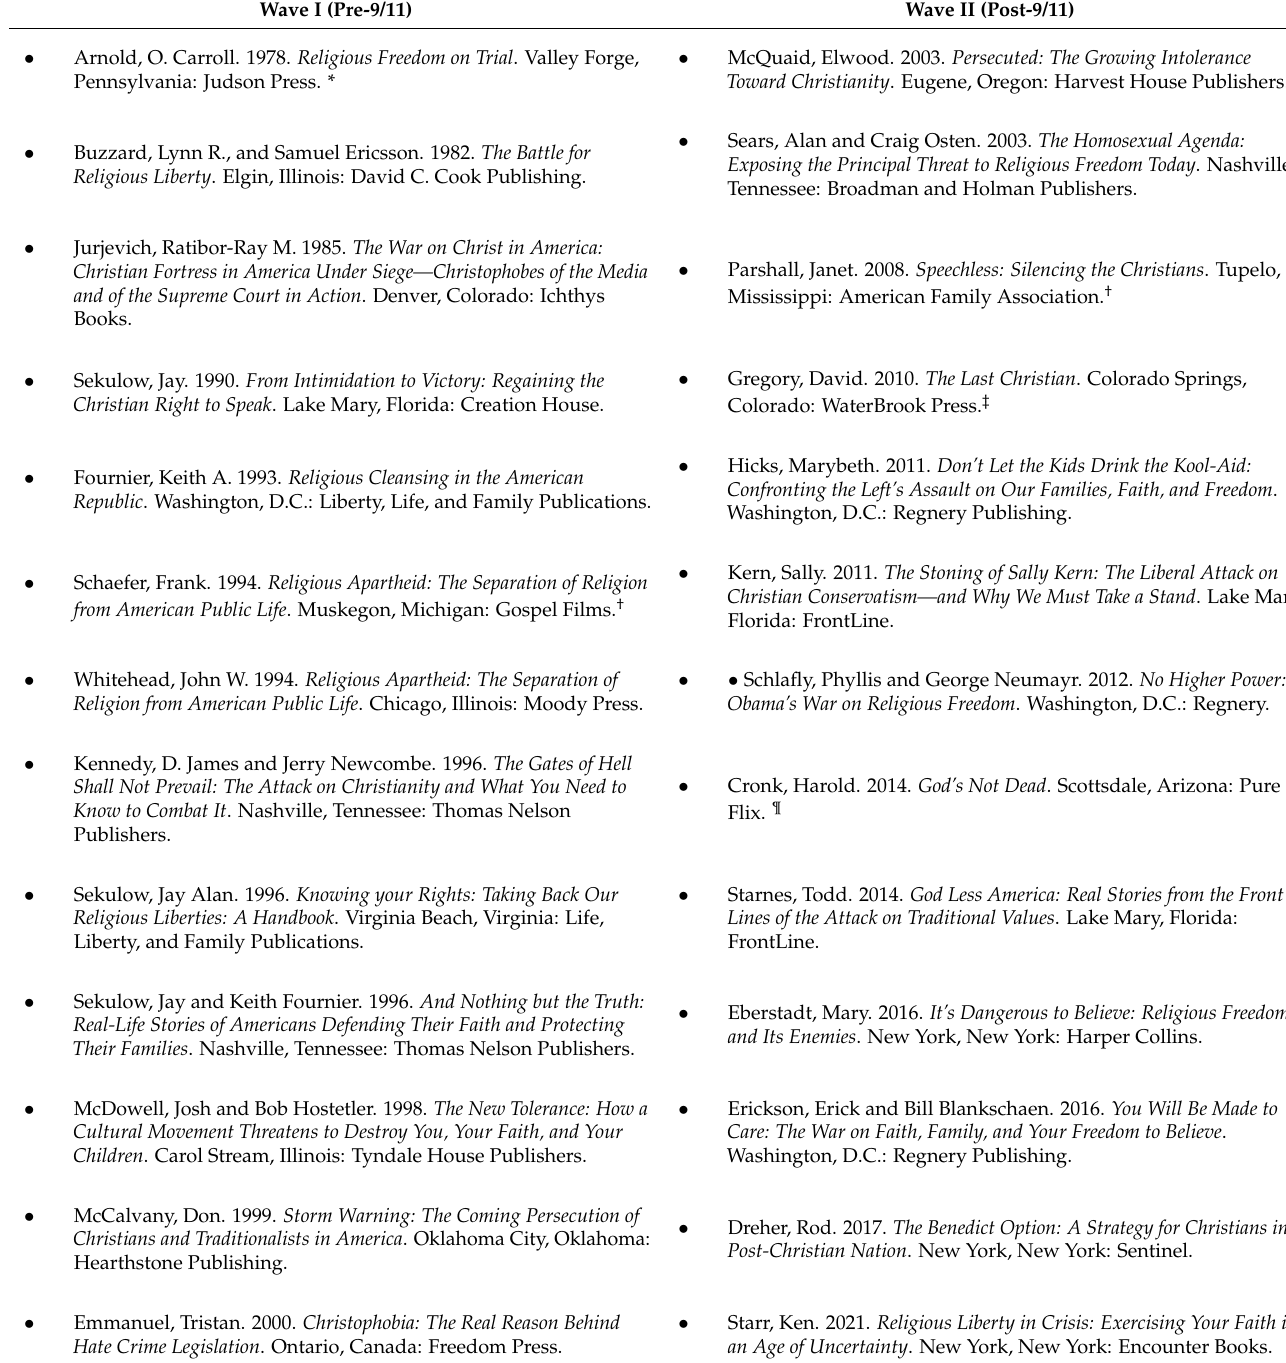
Table 1. Select chronological bibliography of American conservative Christian persecution discourse by